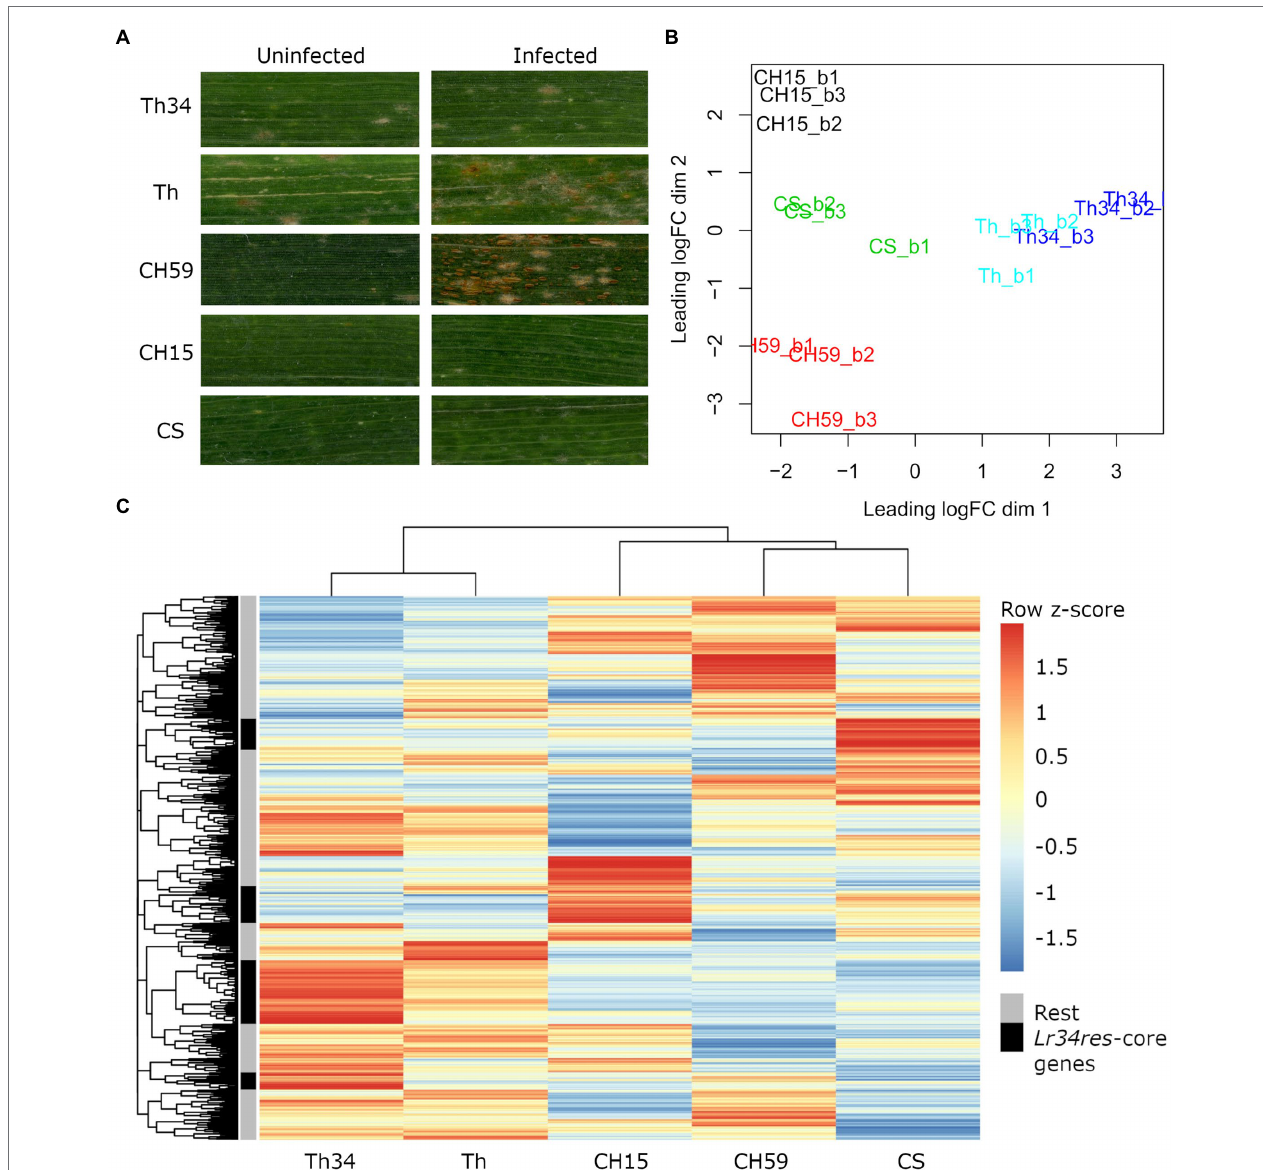
FIGURE 1 | Phenotypic and transcriptomic comparison of field-grown wheat. (A) Flag leaves from five different wheat lines. Leaf samples were collected from uninfected and leaf rust infected wheat plants at late infection stage. (B) RNA sequencing (RNA-Seq) samples, each in three biological replicates, were collected from five wheat lines under uninfected conditions. Only genes with an expression value of >5 cpm in at least three samples were selected. Clustering was performed with the function plot multi-dimensional scaling (MDS) from the R package edgeR. Red: CH59; green: CS; black: CH15; light blue: Th; and blue: Th34. (C) For each gene, we calculated the average Reads Per Kilobase of transcript per Million reads mapped (RPKM) value from the three biological replicates. The R function pheatmap was used to scale the average RPKM values into Z -scores and to draw the heatmap. The five most representative heatmap clusters containing the wheat homologs of the Lr34res -responsive core genes (see text) are highlighted in black. Note that these five clusters correspond to sets of genes that are strongly upregulated in the Lr34res -containing lines. Wheat lines: Thatcher (Th), Thatcher- Lr34 (Th34), Chinese Spring (CS), AUS 27378 (CH15), and AUS 27438